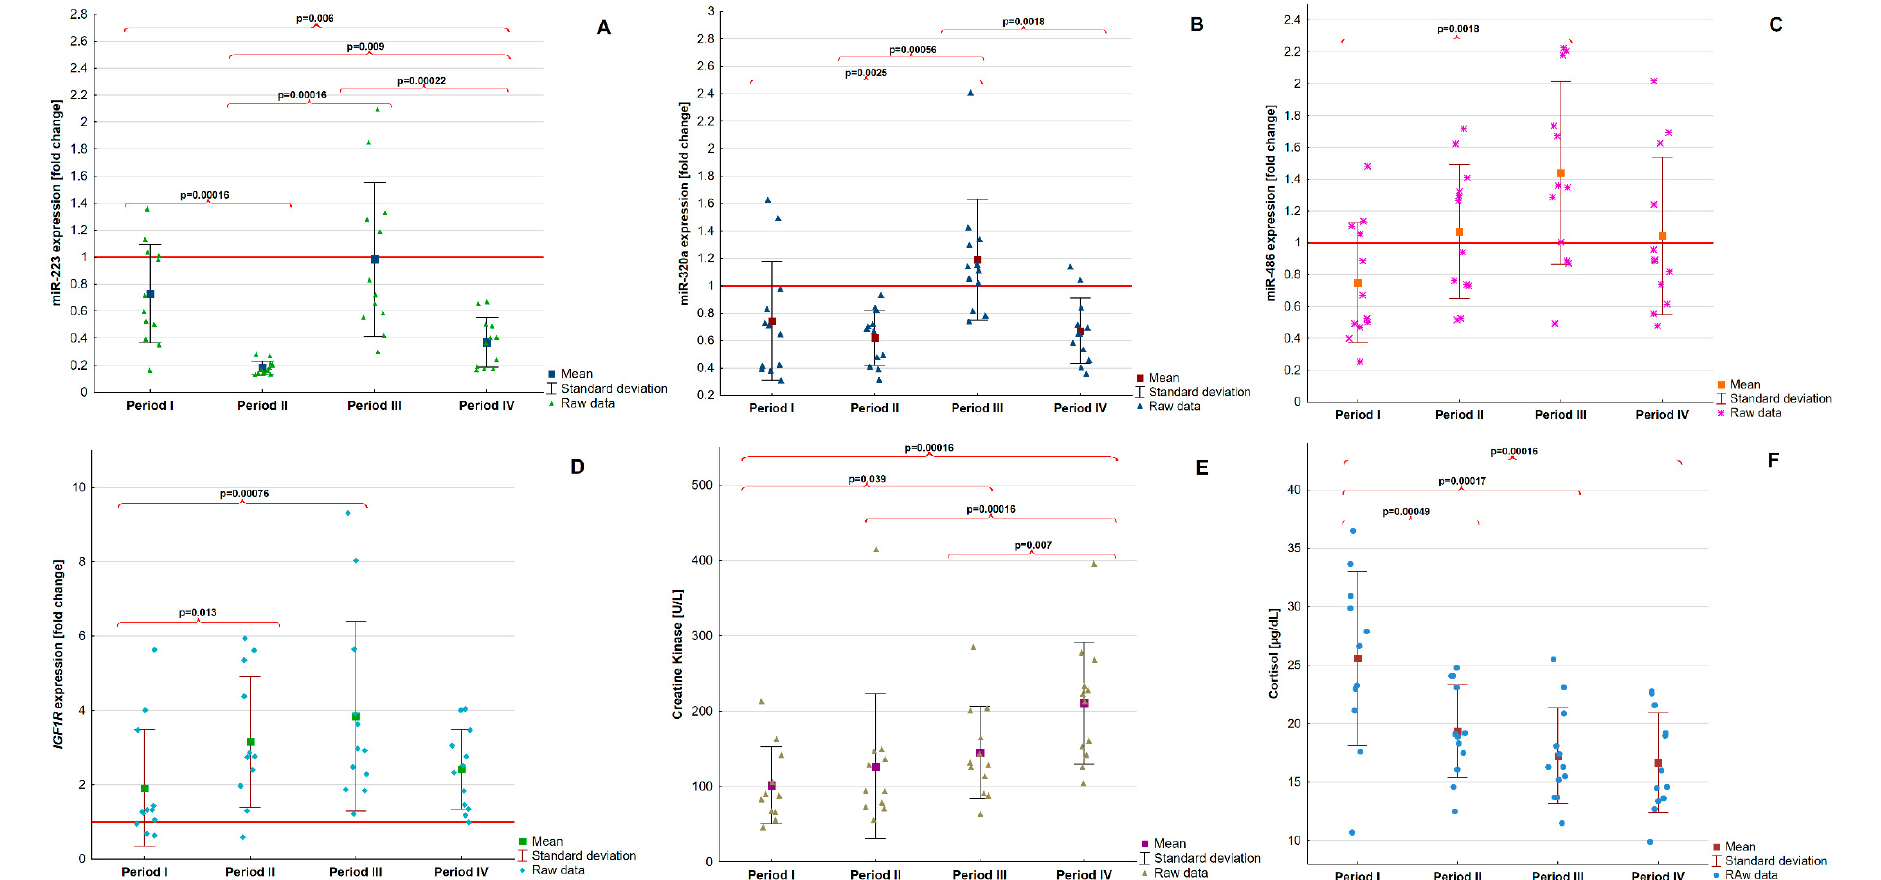
Figure 1. Differences between studied parameters during training periods. Abbreviations: IGF1R , insulin-like growth factor 1 receptor gene; miR, microRNA. A p -value was estimated by repeated-measures ANOVA. Statistically significant differences are in bold.